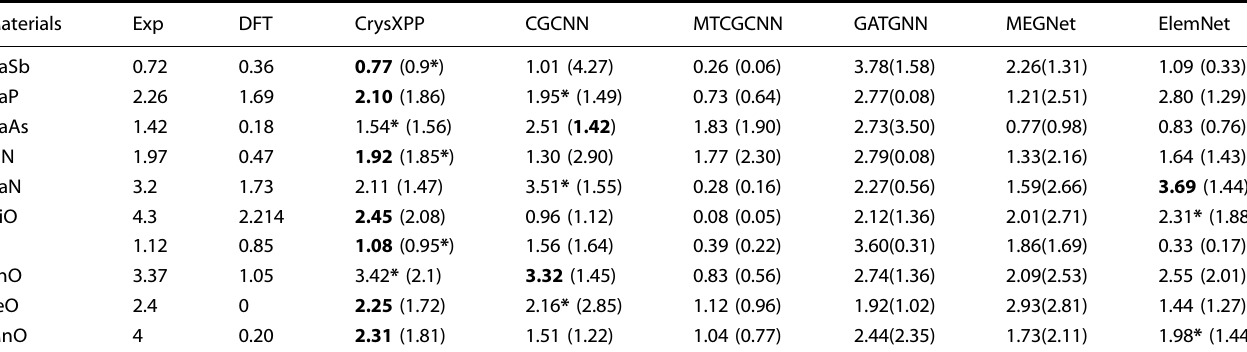
Table 4. Experiment (Exp) and predicted value for Band Gap for 10 crystals calculated by DFTand other machine learning models after fi ne-tuned by experimental data. The predicted value without fi ne tuning by experimental data is provided in the bracket. The closest prediction is marked in bold and the second-best with * . CrysXPP predicts closest to the ground truth after fi ne tuning with experimental